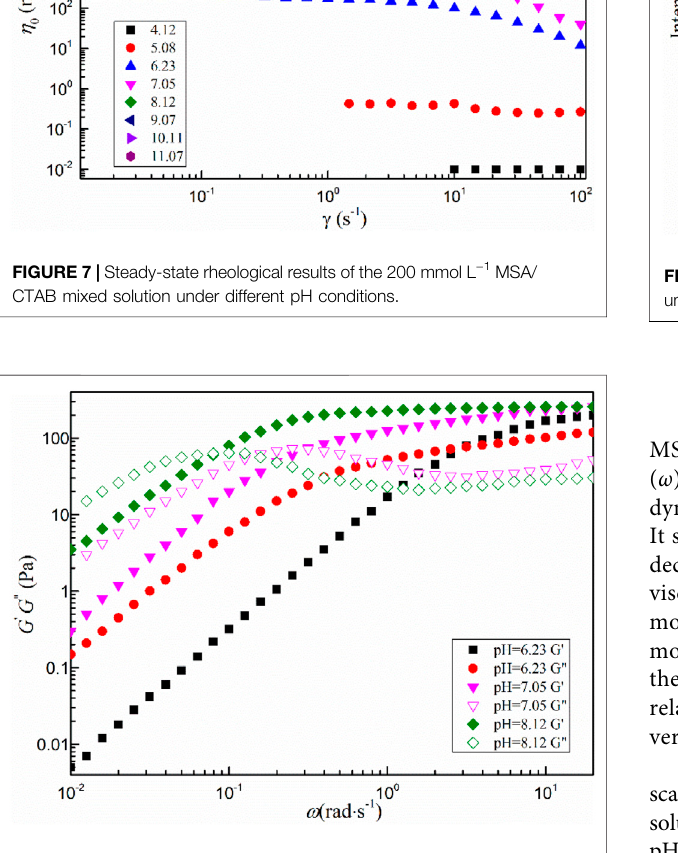
FIGURE 8 | Variation of viscoelastic modulus of the MSA/CTAB mixed solution with oscillation angle frequency under different pH conditions.